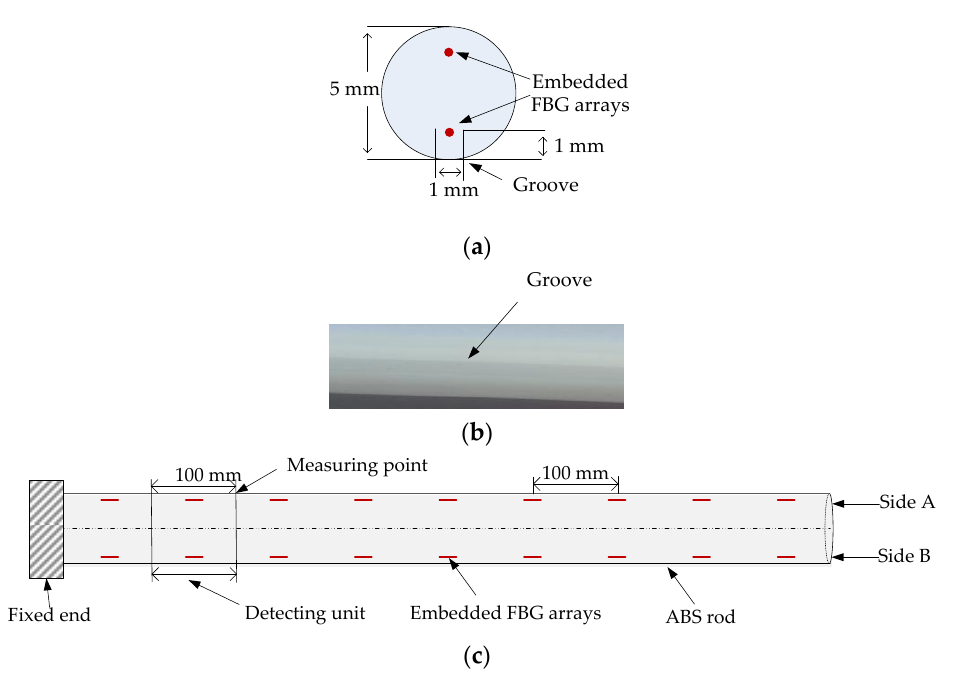
Table 1. The detailed parameters of fiber Bragg grating (FBG) sensing arrays.